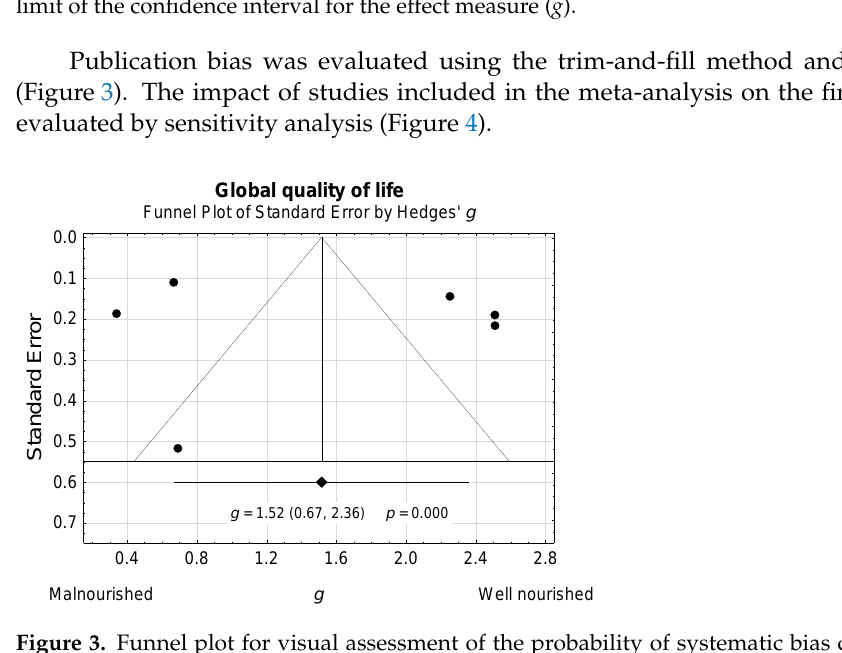
Figure 4. Sensitivity analysis for the impact of individual study exclusion on summary global QoL results (Hedge’s g). QoL in terms of the physical, social, and role functioning domains of the EORTC QLQ-C30 was evaluated in five studies. Emotional functioning was evaluated in four studies, and cognitive functioning in only three. Clear heterogeneity was found in all of these studies. Heterogeneity analysis results are listed in Table 3. Table 3. Study heterogeneity results for the analyzed QoL domains. Quality of Life Domains